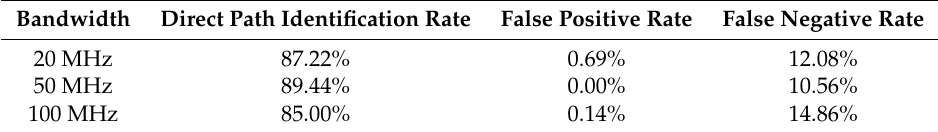
Table 3. Direct path identification rate of NC-MUSIC in UMi scenario with 20 MHz, 50 MHz and 100 MHz bandwidth.